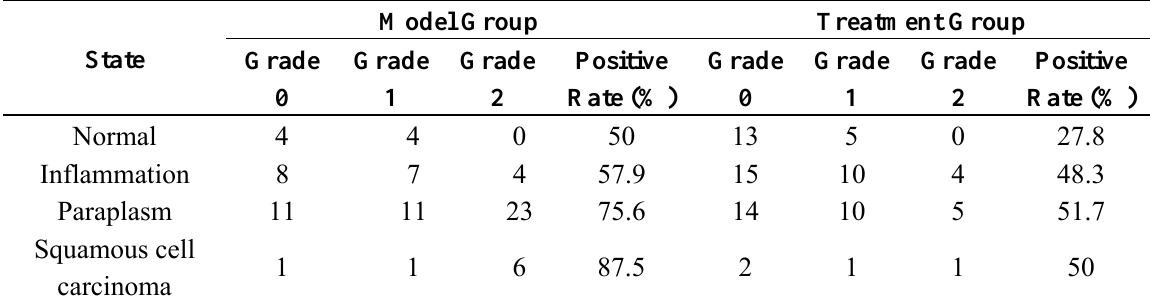
Table 7. Caspase-3 positive expression rates in model and treatment groups.